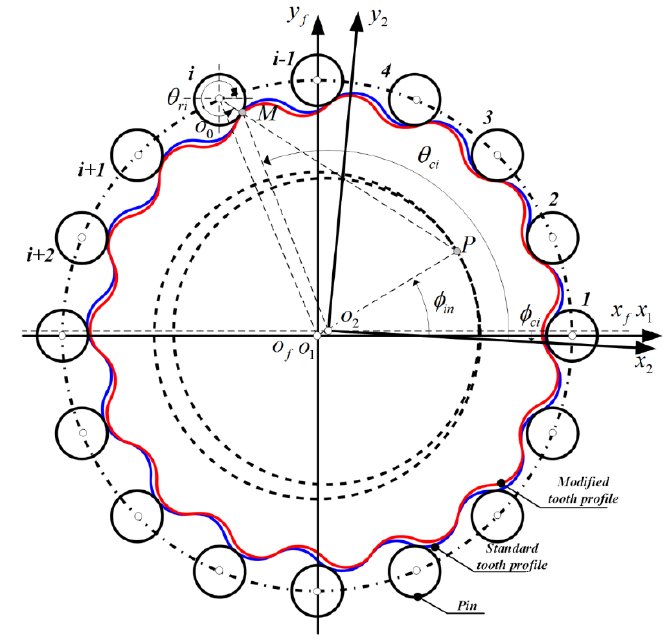
Figure 6. Coordinate systems for unloaded tooth contact analysis.